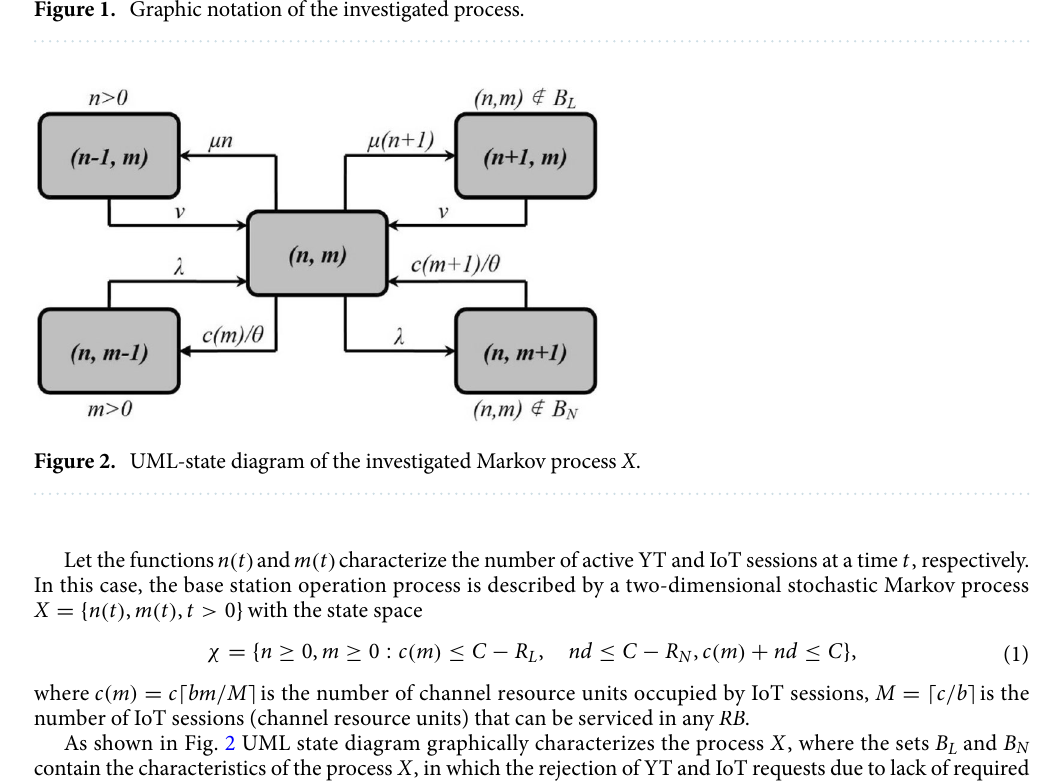
Figure 1. Graphic notation of the investigated process.